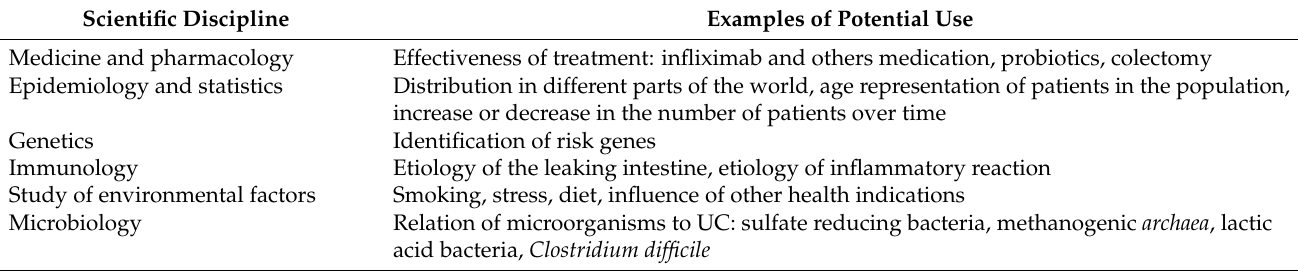
Table 3. Perspectives of using meta-analysis for research of ulcerative